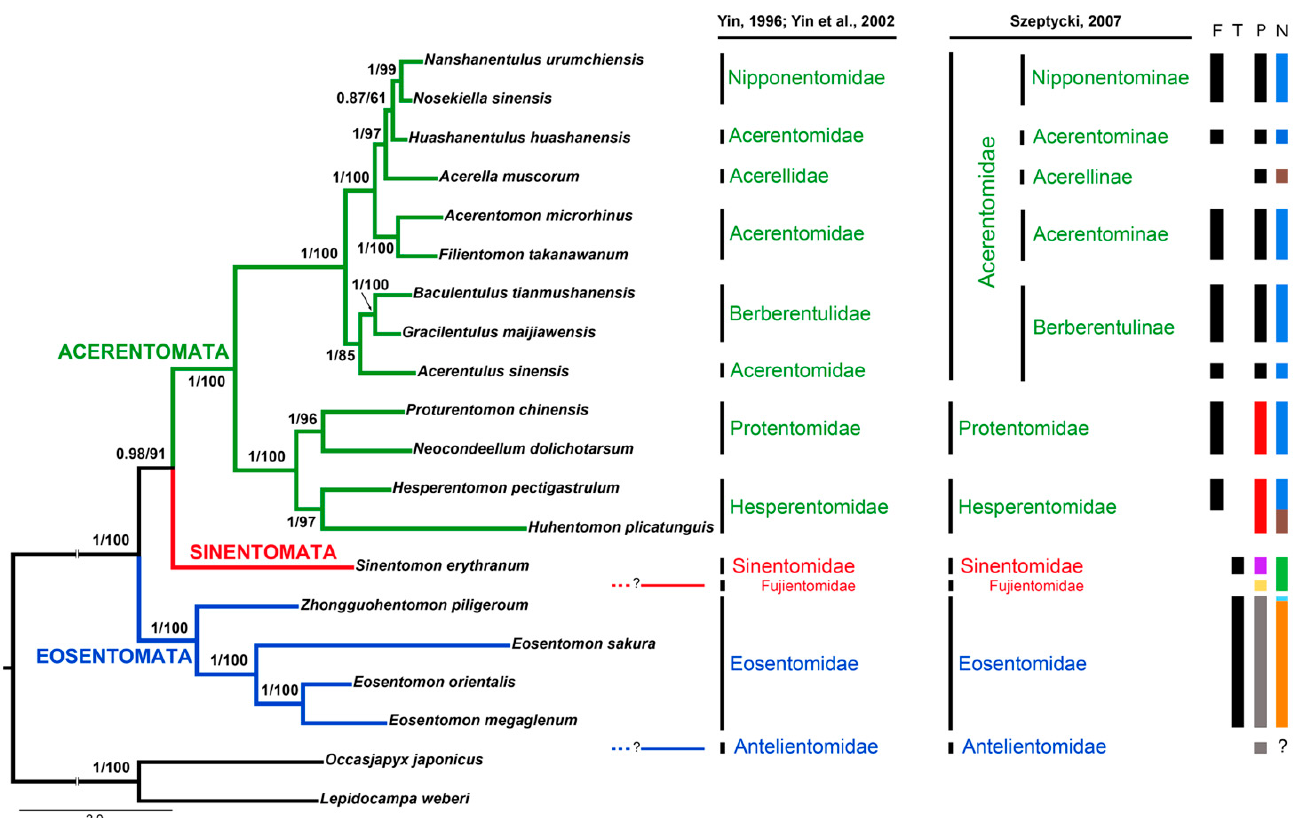
Figure 4. Phylogenetic analysis of Protura based on cox1, 18S and 28S concatenated sequences. Support at nodes is shown as posterior probability / bootstrap. The presence of selected morphological characters is indicated at far right: F, presence of flagellum; T, presence of tracheal system; P, shape of pseudoculi ( black = peach-shaped; red = pear-shaped; violet = elliptical; yellow = rhomboidal; gray = circular); N, shape of nucleus ( blue = spiral; brown = ovoidal; green = spherical; light blue = dumbbell-like; orange = ring-like). The placement of Fujientomon dicestum (Fujientomidae) is based on the reduced 18S and 28S data set and is to be considered tentative. The most likely position of Antelientomidae (not included in this study, but discussed in the text) is indicated for reference. Both classification systems [2,27,28] used throughout the text are shown.